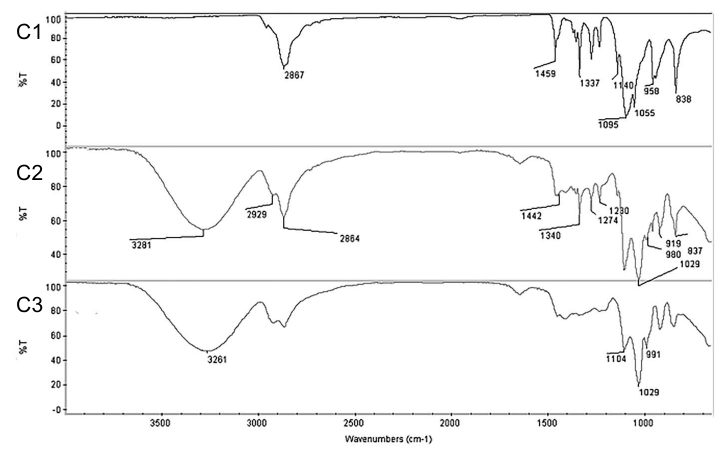
Figure 7. ( A ) 1 H-NMR, ( B ) 13 C-NMR, and ( C ) the IR spectra of (A1, B1, C1) original F127, (A2, B2, C2) separated reaction mixture and (A3, B3, C3) the purified gold nanoparticles.